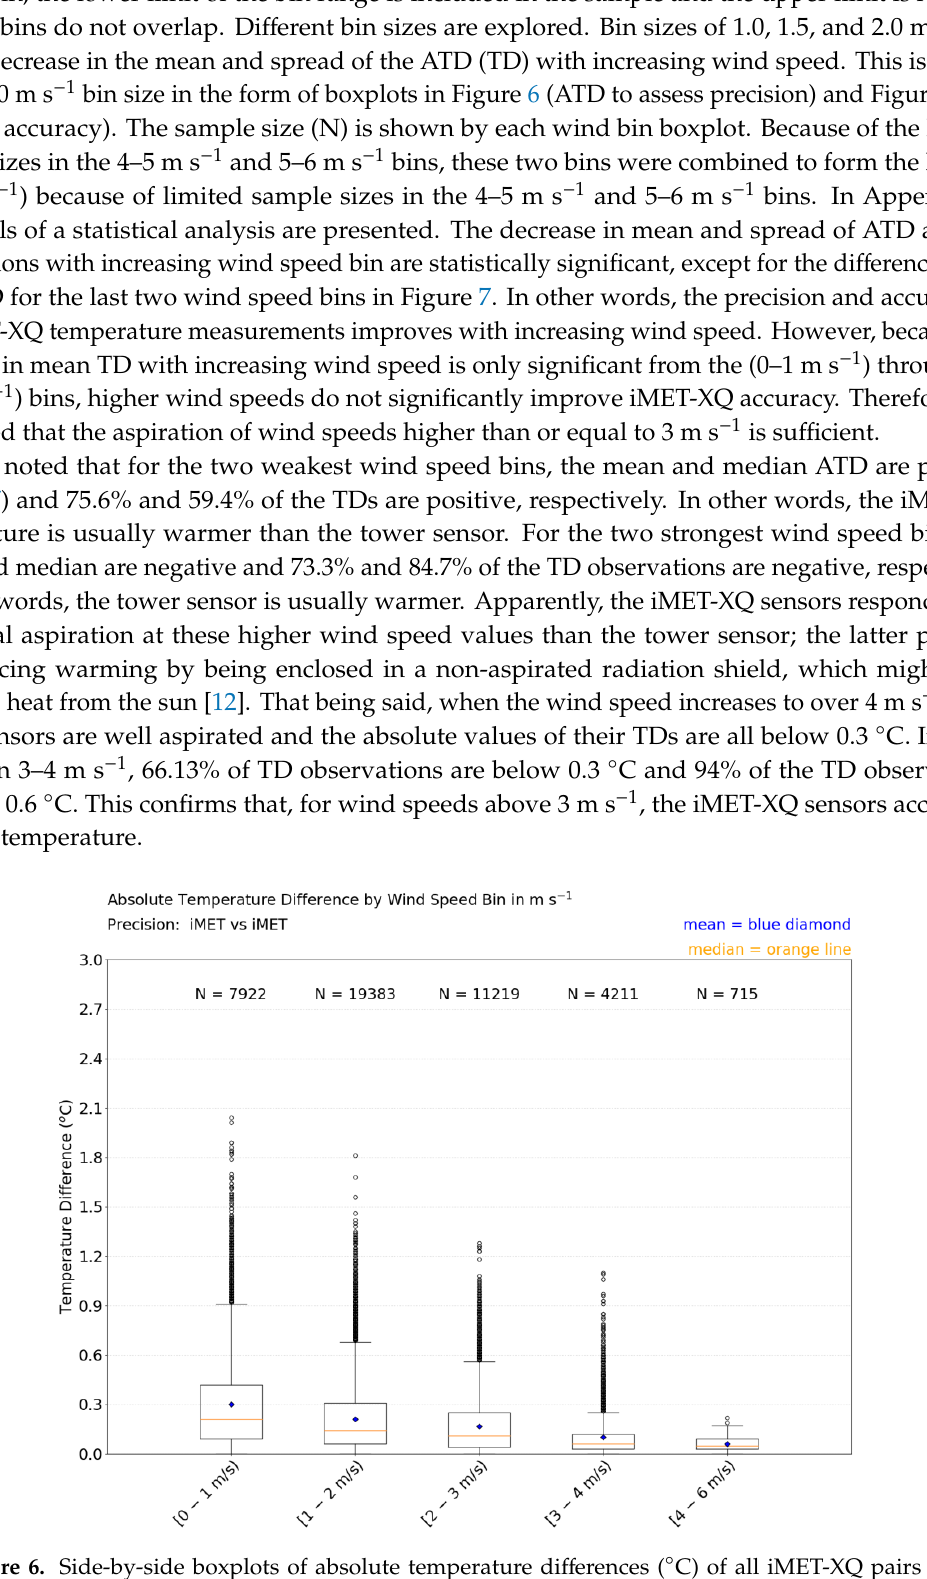
Figure 6. Side-by-side boxplots of absolute temperature differences (°C) of all iMET-XQ pairs by 1.0 m s −1 sized wind bins, for the daytime Tower experiments (i.e., dusk experiments excluded). The sample size (N) for each bin is given above each boxplot.